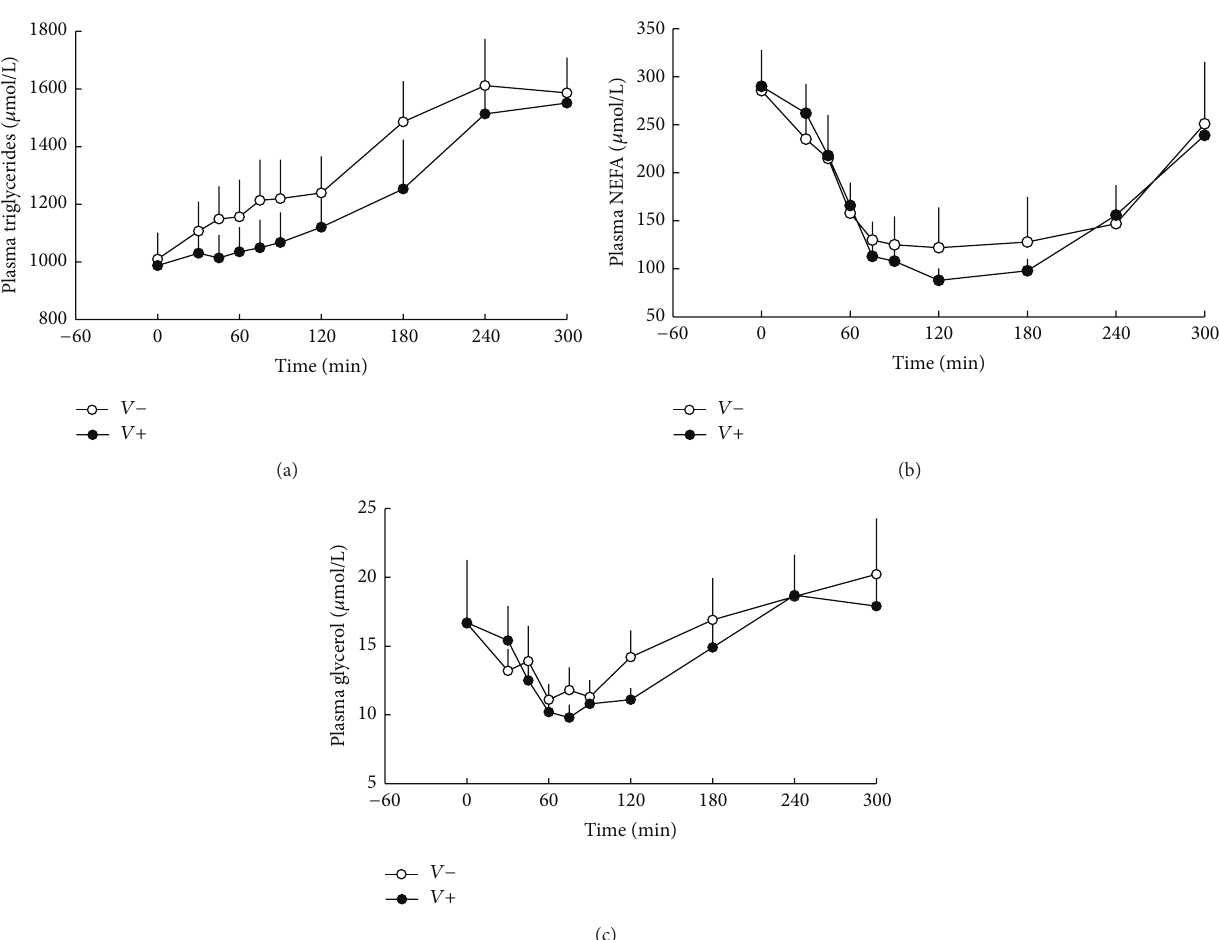
Figure 3: Arterial plasma triglycerides ( 𝑝 = 0.0439 ) (a), NEFA (p = NS) (b), and glycerol (p = NS) (c) levels in subjects consuming vinegar ( V +) or placebo ( V − ). At 𝑡 = 0 min, a mixed meal was